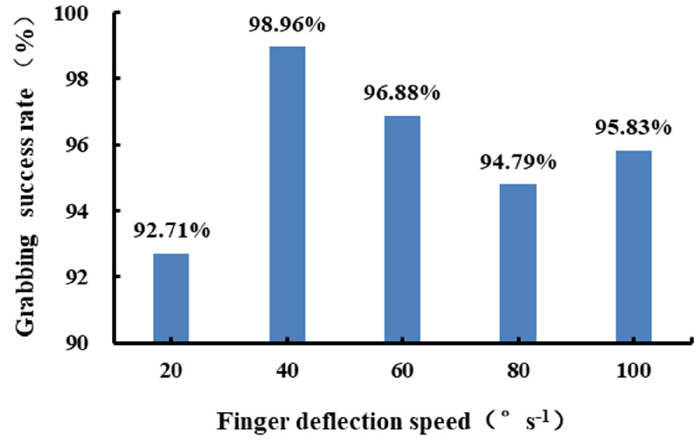
Figure 19. Grabbing success rate at different finger deflection speeds.